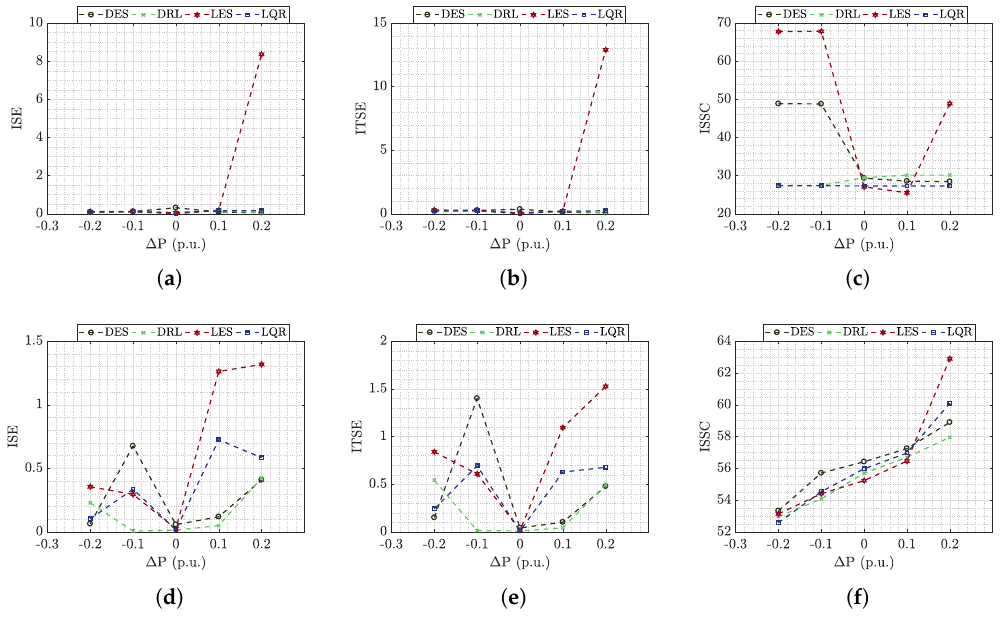
Figure 20. ( a ) Integral of squared error (ISE), ( b ) integral of time-weighted squared error (ITSE) and ( c ) integral of squared signal of control (ISSC) during the simulation, ( d ) ISE, ( e ) ITSE and ( f ) ISSC during the test for buck-buck